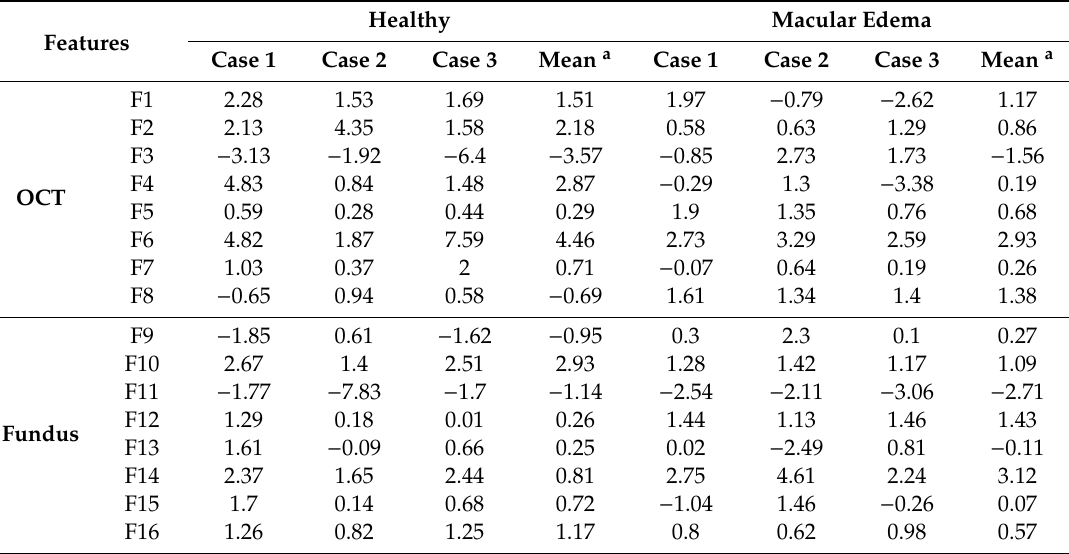
Table 4. Selected fundus and OCT features from healthy and ME subjects.